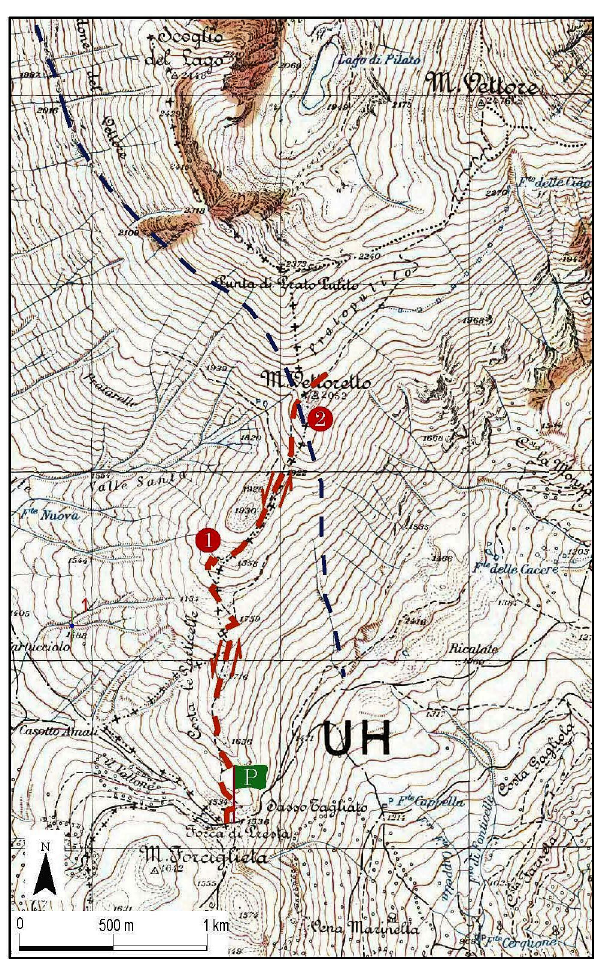
Figure 13. The proposed itinerary for crossing the fault plain on the southwestern side of Mount Vettore. Note: P – parking area; 1 and 2 – stop. Blue dashed line = the fault. © 2020 Marche